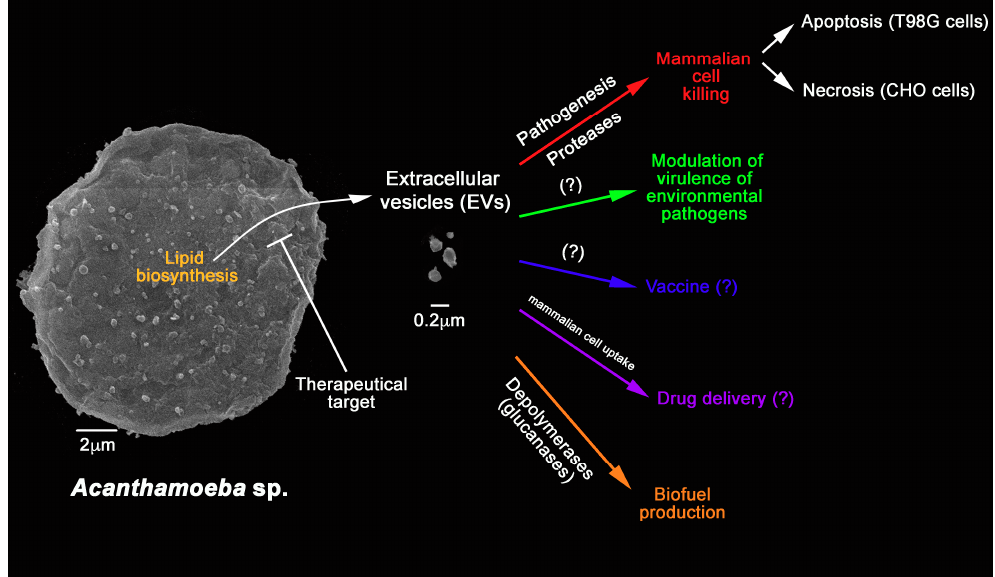
Figure 2. Overview of the characterized functions of A. castellanii EVs and their potential applications in bioengineering and biomedical sciences. A. castellanii EVs’ synthesis could be target for therapy. They are also known to participate in the pathogenesis of A. castellanii by killing mammalian